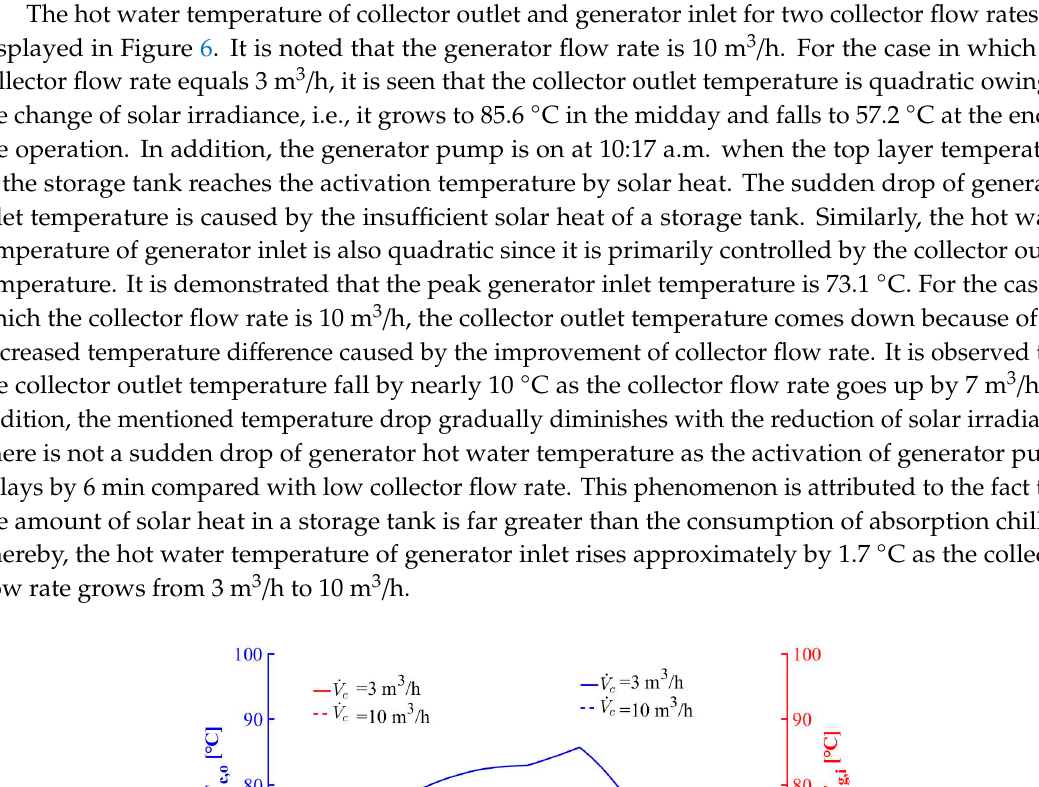
Figure 6. Hot water temperature for different